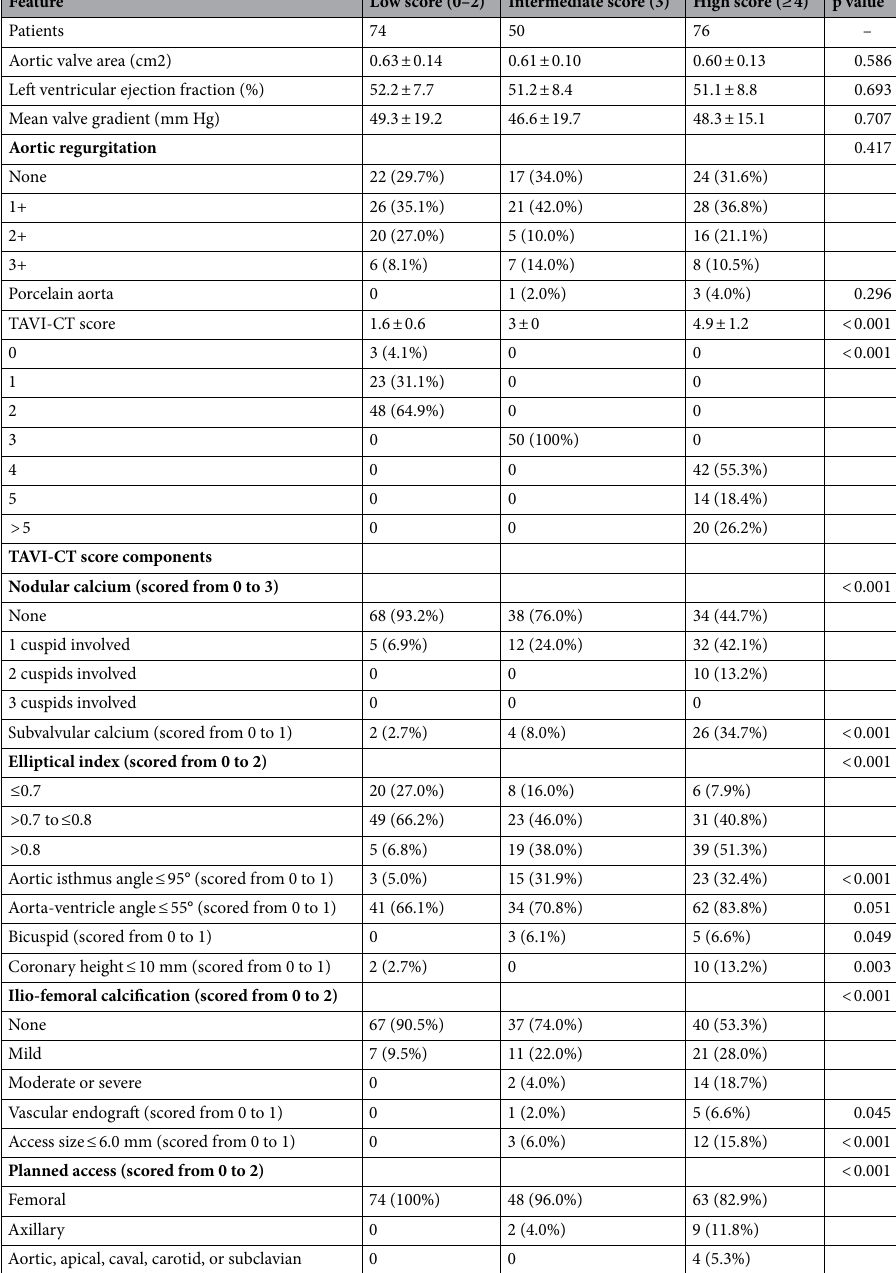
Table 2. Imaging features according to TAVI-CT (transcatheter aortic valve implantation-computed tomography)